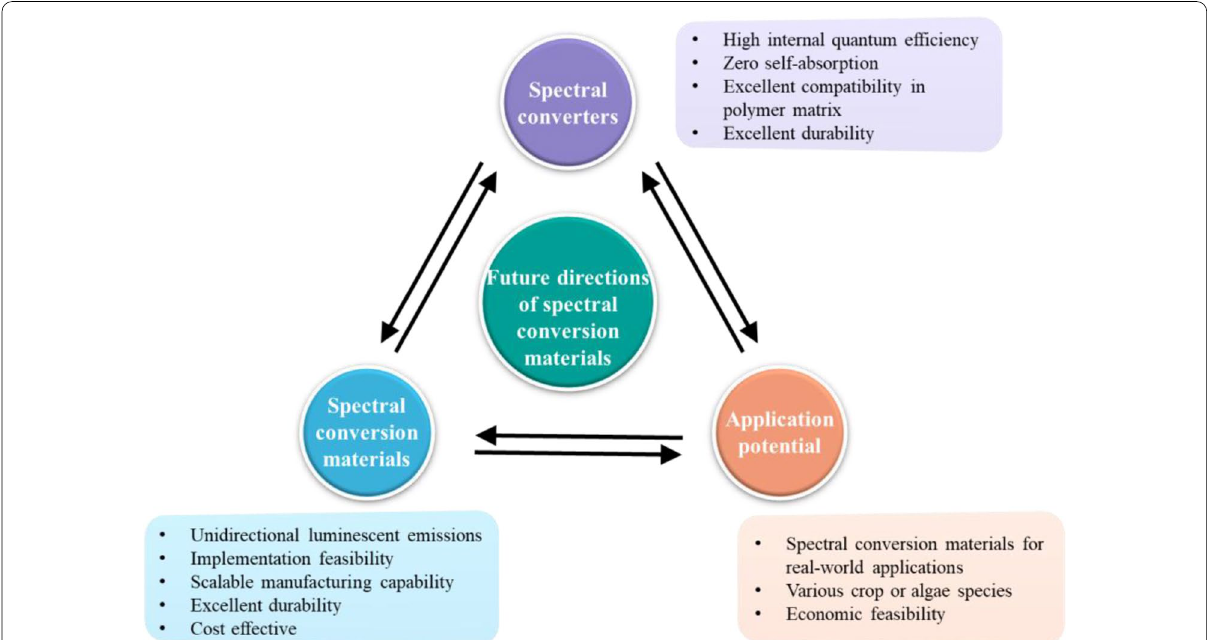
Fig. 12 Recommendations for future directions of spectral conversion materials to enhance